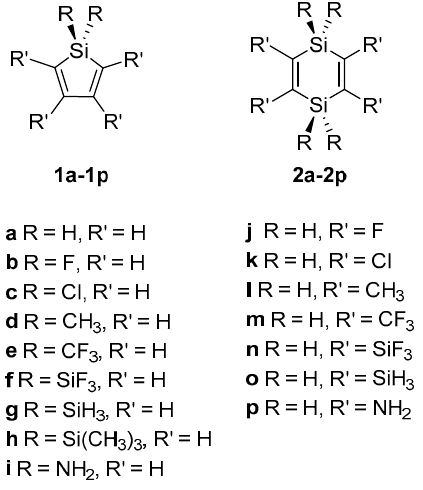
Figure 2. The compounds contained in the present study.